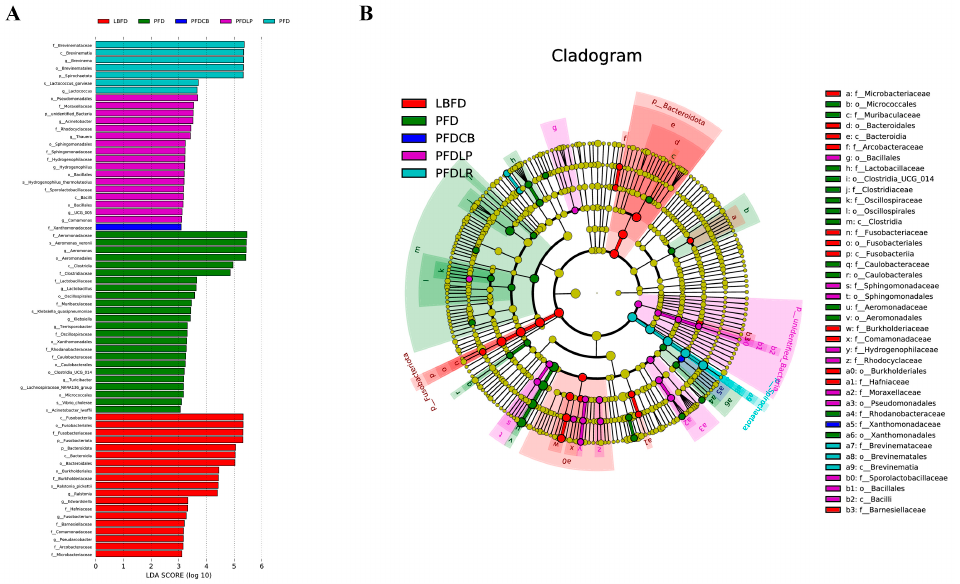
Figure 10. Intergroup variation in the relative abundance of the intestinal microbial communities. ( A ) Cladogram of LEfSe. ( B ) Bacterial taxa differentially displayed in the mandarin fish intestinal microbial populations in different feeding groups (LBFD, PFD, PFDCB, PFDLR and PFDLP) after being fed for 28 days were identified via LEfSe using an LDA score threshold of >3. Abbreviations: LBFD, live bait fish feeding group; PFD, pellet-feed feeding group with probiotics free; PFDCB, pellet-feed feeding group with C. butyricum plus; PFDLR, pellet-feed feeding group with L. rhamnosus plus; PFDLP, pellet-feed feeding group with L. plantarum